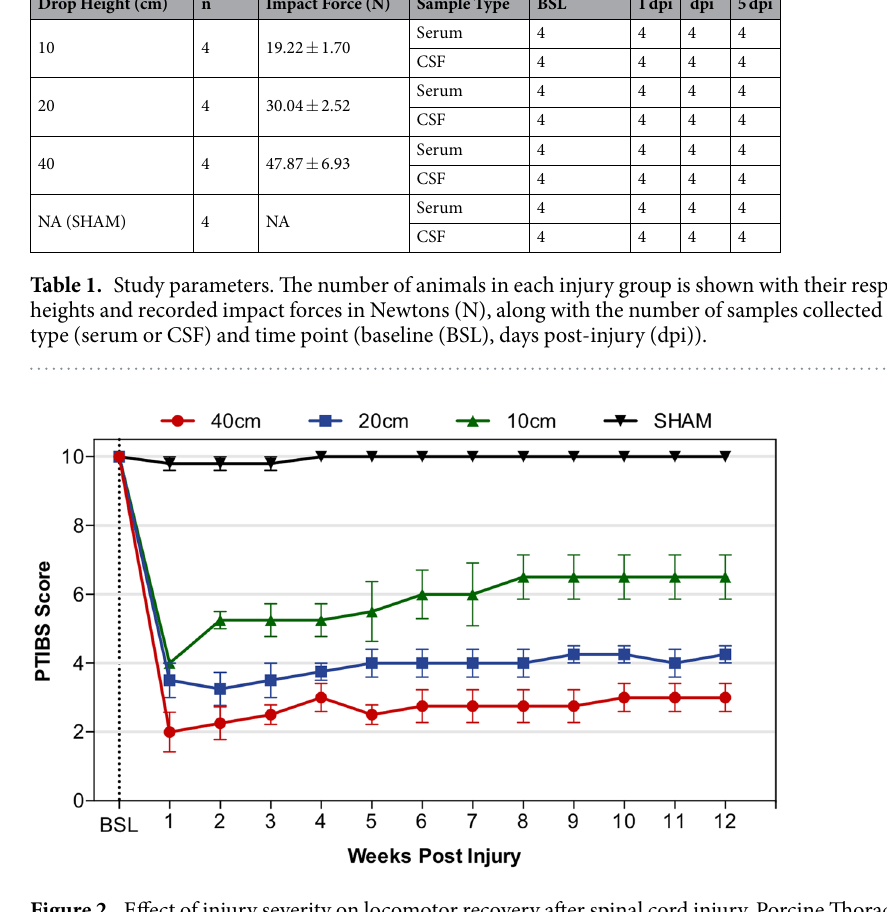
Figure 2. Effect of injury severity on locomotor recovery after spinal cord injury. Porcine Thoracic Injury Behaviour Scale (PTIBS) scores were measured before injury (baseline (BSL)) and weekly for 12 weeks post injury for the 40 (red), 20 (blue), 10 cm (green), and SHAM (black) groups. Datapoints represent mean ± SEM for n = 4 animals per group (see Table